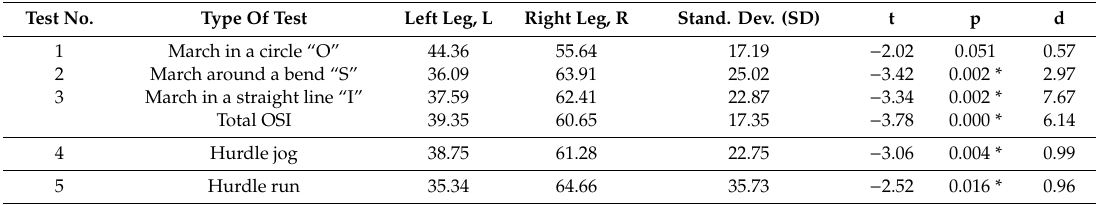
Table 3. Student’s t -test results for the selection of the right and left lead legs during tests at a marching pace and at jogging and running paces (data in %).